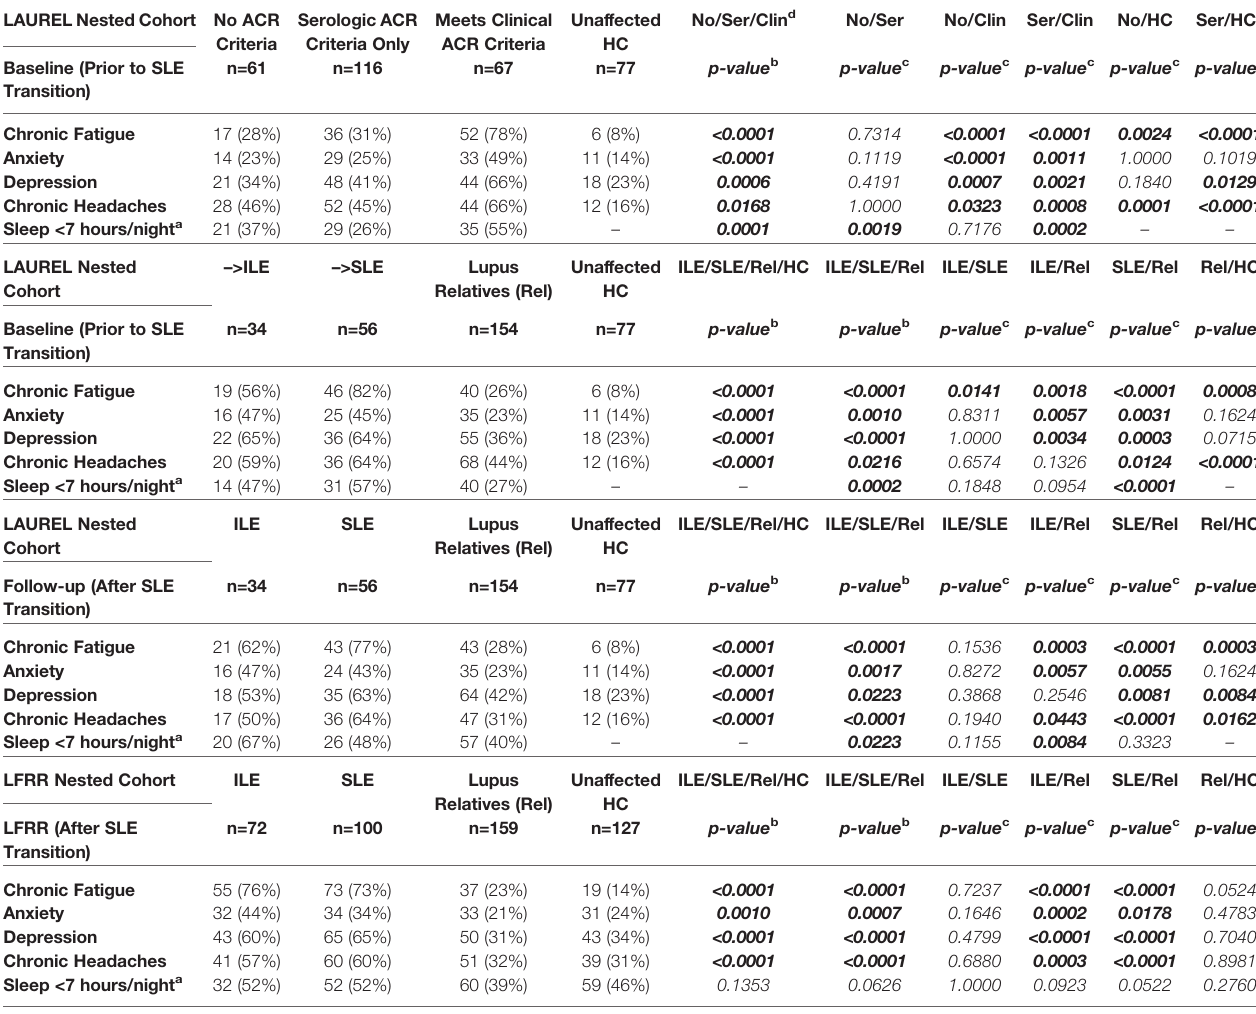
TABLE 2 | Type 2 Symptoms in Lupus Relatives Who Transition to ILE or SLE. LAUREL Nested Cohort No ACR